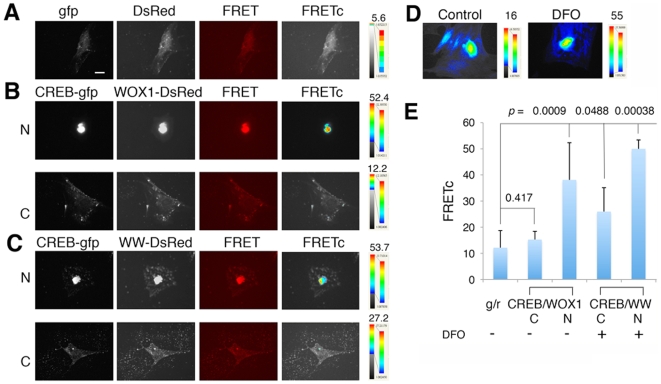
The WW domain area of WOX1 binds CREB most strongly in the nucleus.Rat DRG neurons were cultured overnight and transfected with WOX1-DsRed
and CREB-EGFP. (A) In controls, EGFP did not bind DsRed, as
revealed by very low binding energy (FRETc; see color scale). Scale
bar = 20 µm.
(B,C) Both the full-length WOX1 and the WW domain area
bound CREB most strongly in the nuclei rather than in the cytoplasm.
N = nucleus,
C = cytoplasm. (D)
Exposure of neurons to DFO (500 µM) for 2 hours to induce
hypoxic conditions resulted in increased binding of WOX1 with CREB in
both cytoplasm and nuclei. (E) The bar graph shows the
increased binding when both proteins are in the nuclei, and DFO
significantly increased the binding (average ± standard
deviations, n = 7; Student's
t tests for all WOX1/CREB interactions versus
GFP/DsRed).